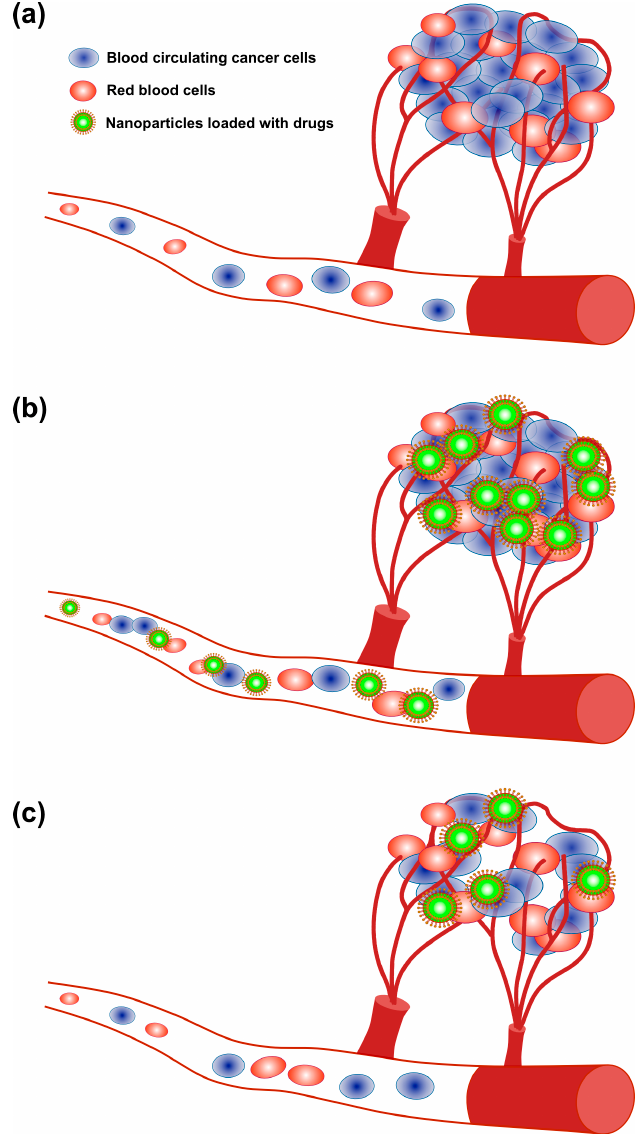
Figure 2. The angiogenesis process and treatment of tumors via nanoparticle delivery. ( a ) Angiogenesis; ( b ) Drug delivery through NPs; ( c ) Tumor reduction.